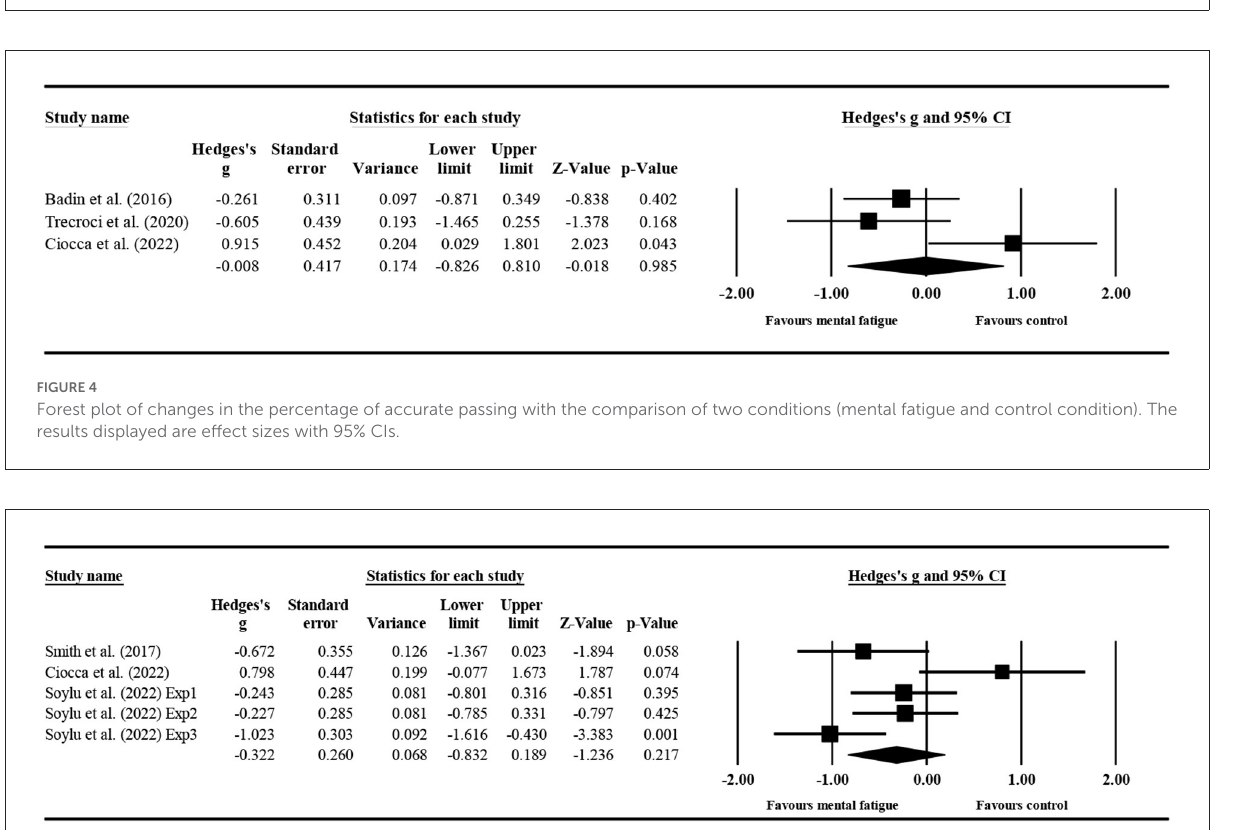
FIGURE3 Forest plot graph of deviation in the number of passes with the comparison of two conditions (mental fatigue and control condition). The results displayed are effect sizes with 95% CIs.